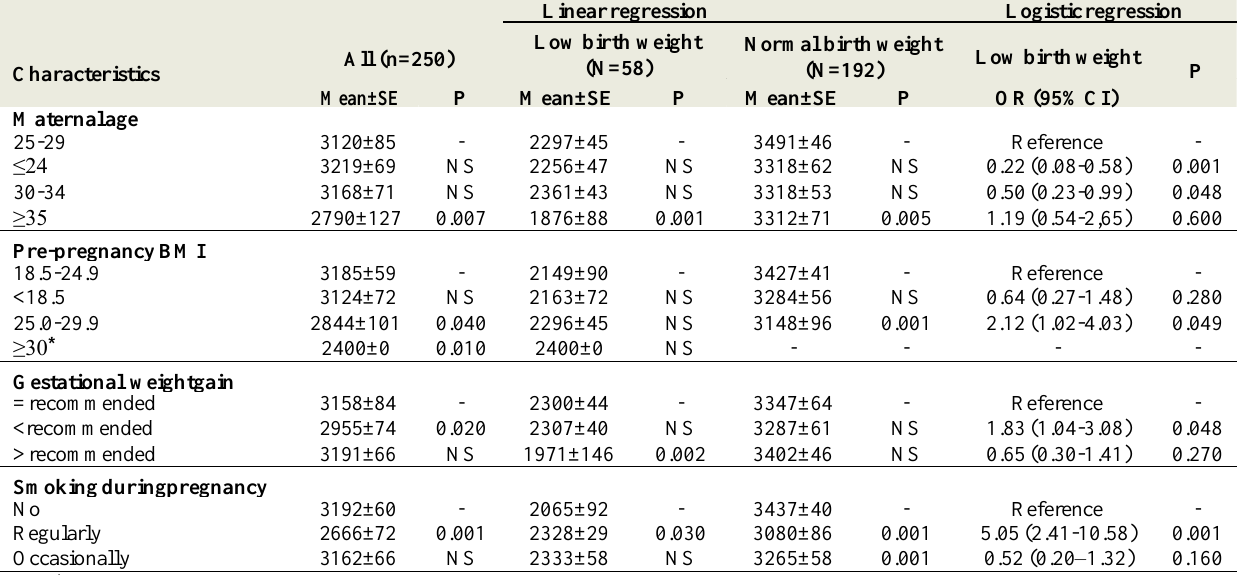
Table 2. Maternal characteristics correlated with normal birth-weight and low birth-weight(g)